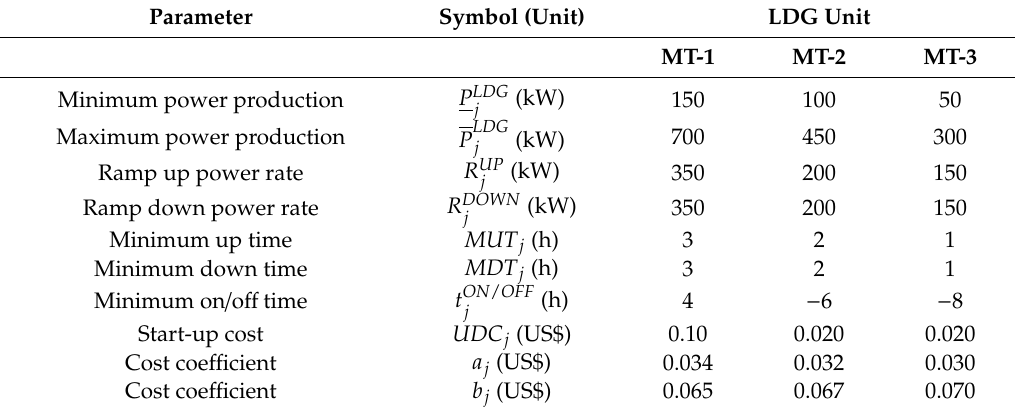
Table 3. Modelling and cost parameters for the local dispatchable generation (LDG) units [24,31].